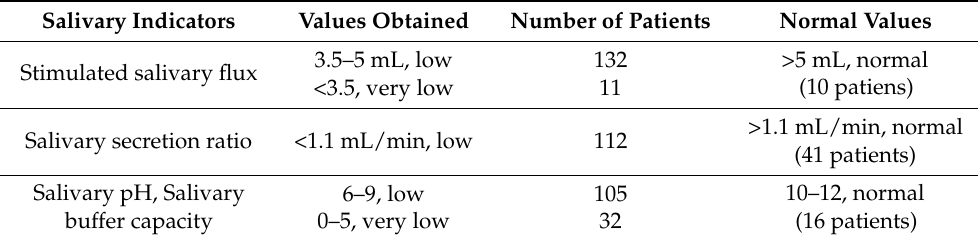
Table 1. The salivary indicators for stimulated saliva and number of